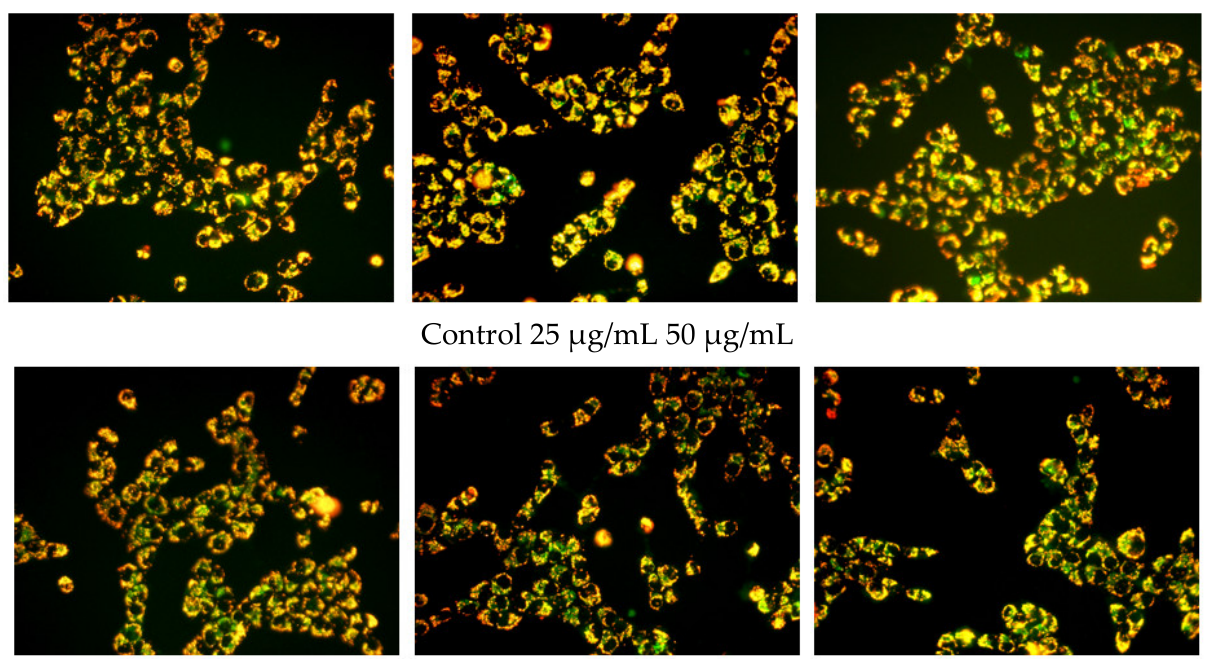
Figure 8. Effect of OF/PVP/PVA hydrogels on mitochondrial membrane potential of CAL-27 JC-1 staining was performed. The fluorescence was observed under a microscope (×40).